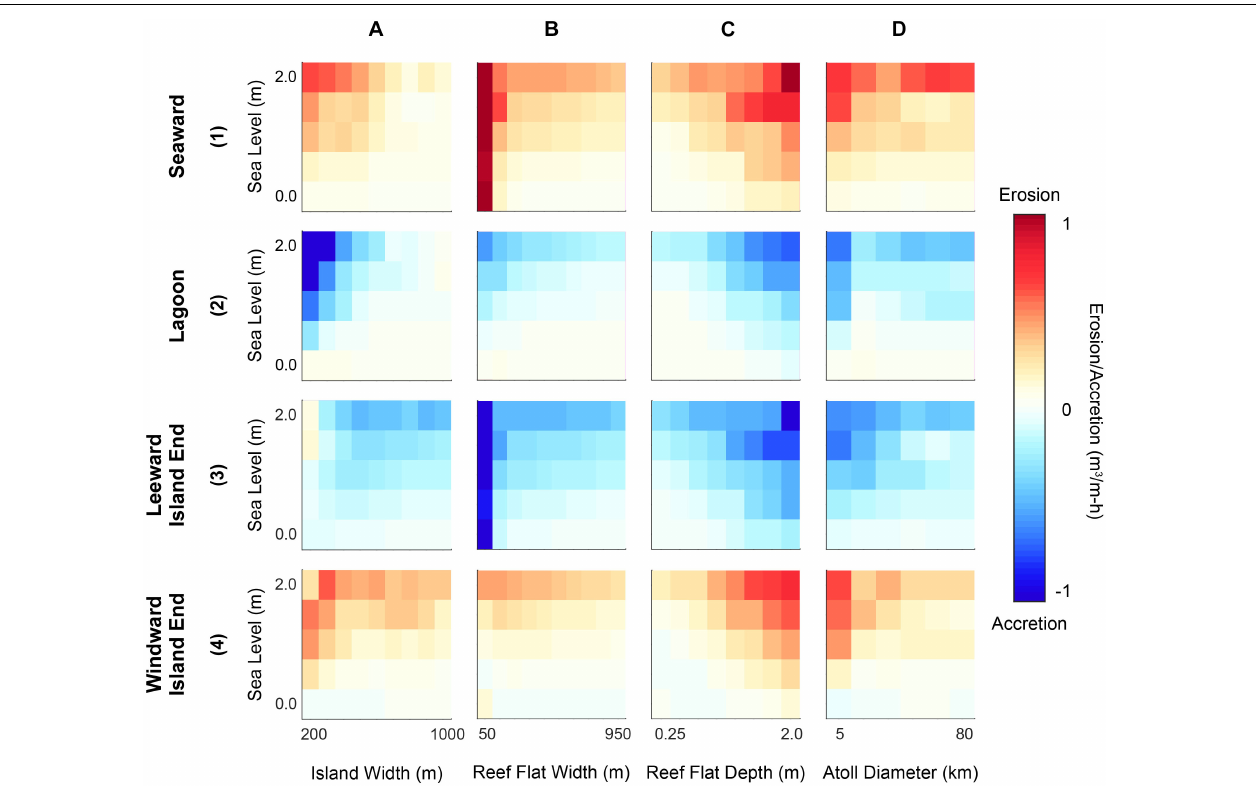
FIGURE 4 | Relative changes in shoreline erosion/accretion magnitudes with morphological parameter (x-axes) and SLR (y-axes) for the oblique island. Rows describe (1) seaward, (2) lagoon, (3) leeward island end, and (4) windward island end shorelines; columns denote morphological parameters (A) island width, (B) reef flat width, (C) reef flat depth, and (D) atoll diameter. Red indicates net erosion and blue net accretion, with increasing color intensity indicating greater magnitude. The color ramp is linear, but absolute magnitudes are unlisted to address only relative changes.